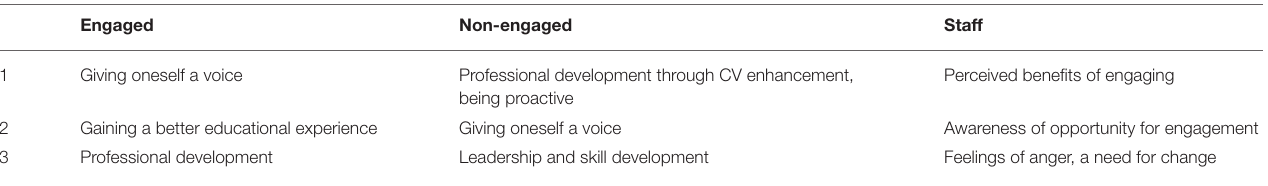
TABLE 2 | The top three ranked themes which resulted from the engaged and non-engaged student focus groups as well as the student-facing staff focus